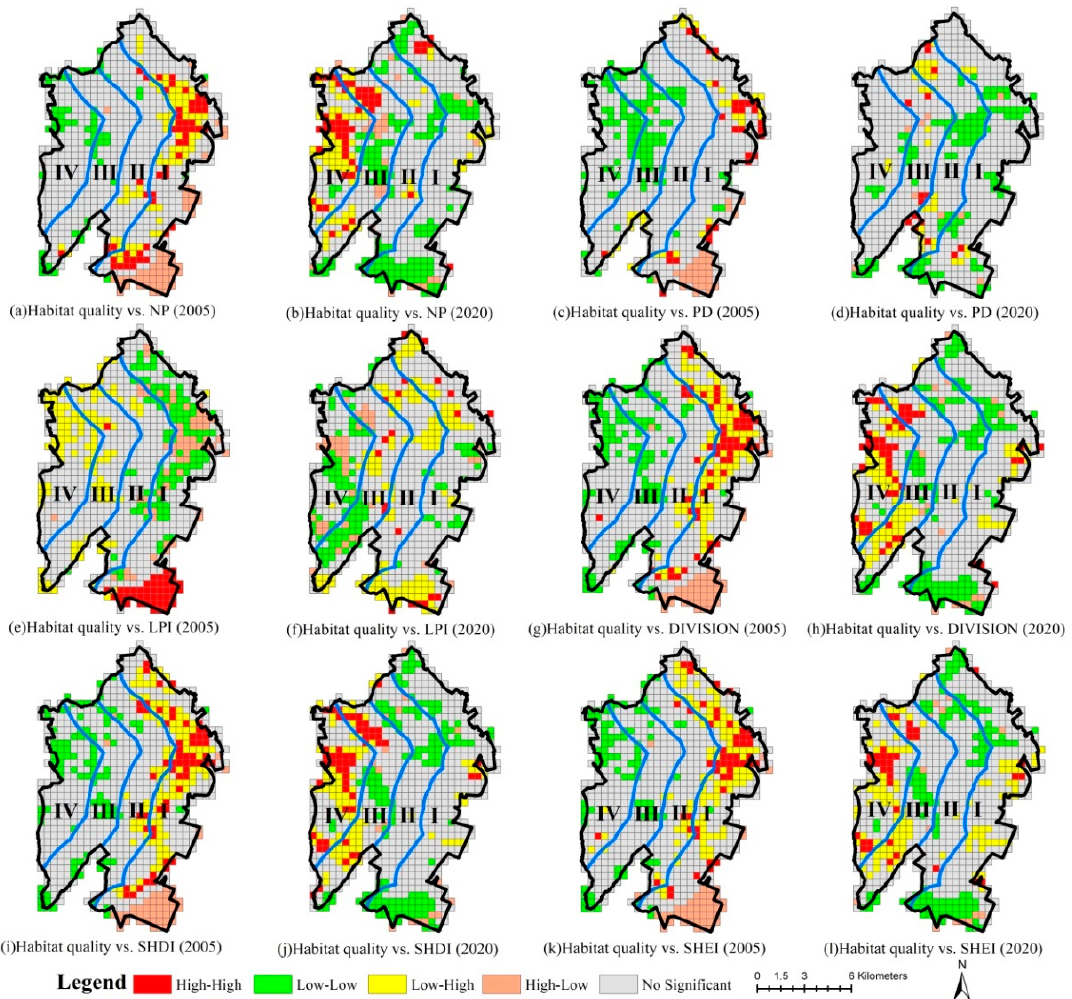
Figure 7. LISA cluster map between habitat quality and landscape metrics in 2005 and 2020. (Gradient I (0–2 km), gradient II (2–4 km), gradient III (4–6 km) and gradient IV (>6 km) from the coastline to the inland).